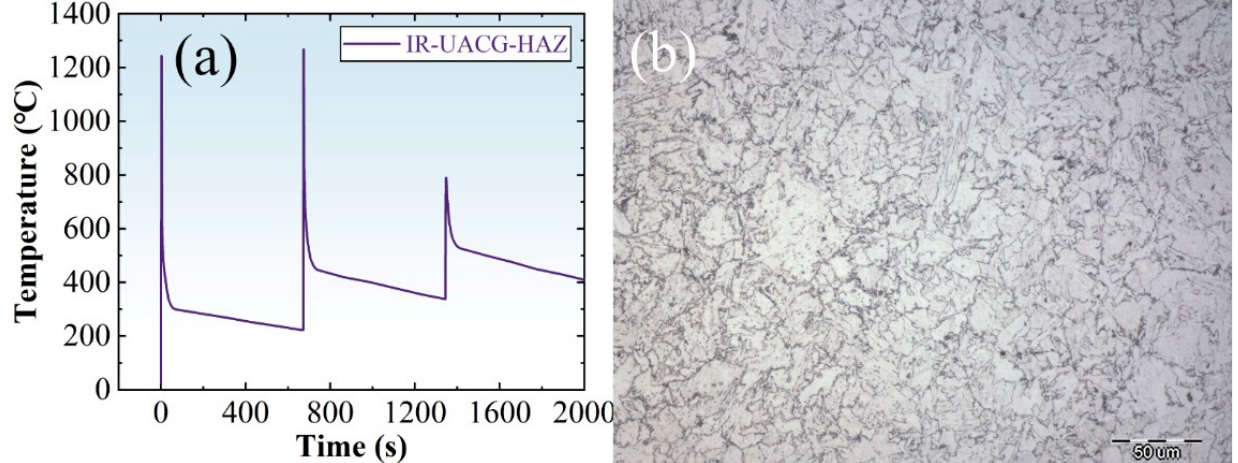
Figure 12. Thermal processes of IRCG-HAZ and the thermal simulation microstructures (with a magnification of 500): ( a ) thermal cycles calculated for thermal simulation of IRCG-HAZ; ( b ) micro- structures of thermal simulated IRCG-HAZ.